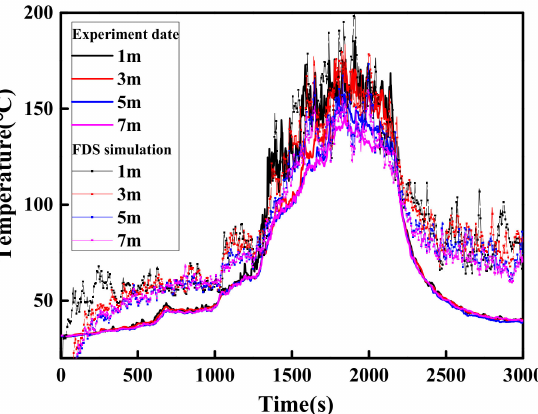
Figure 7. Comparison between the experiments and FDS simulations near the